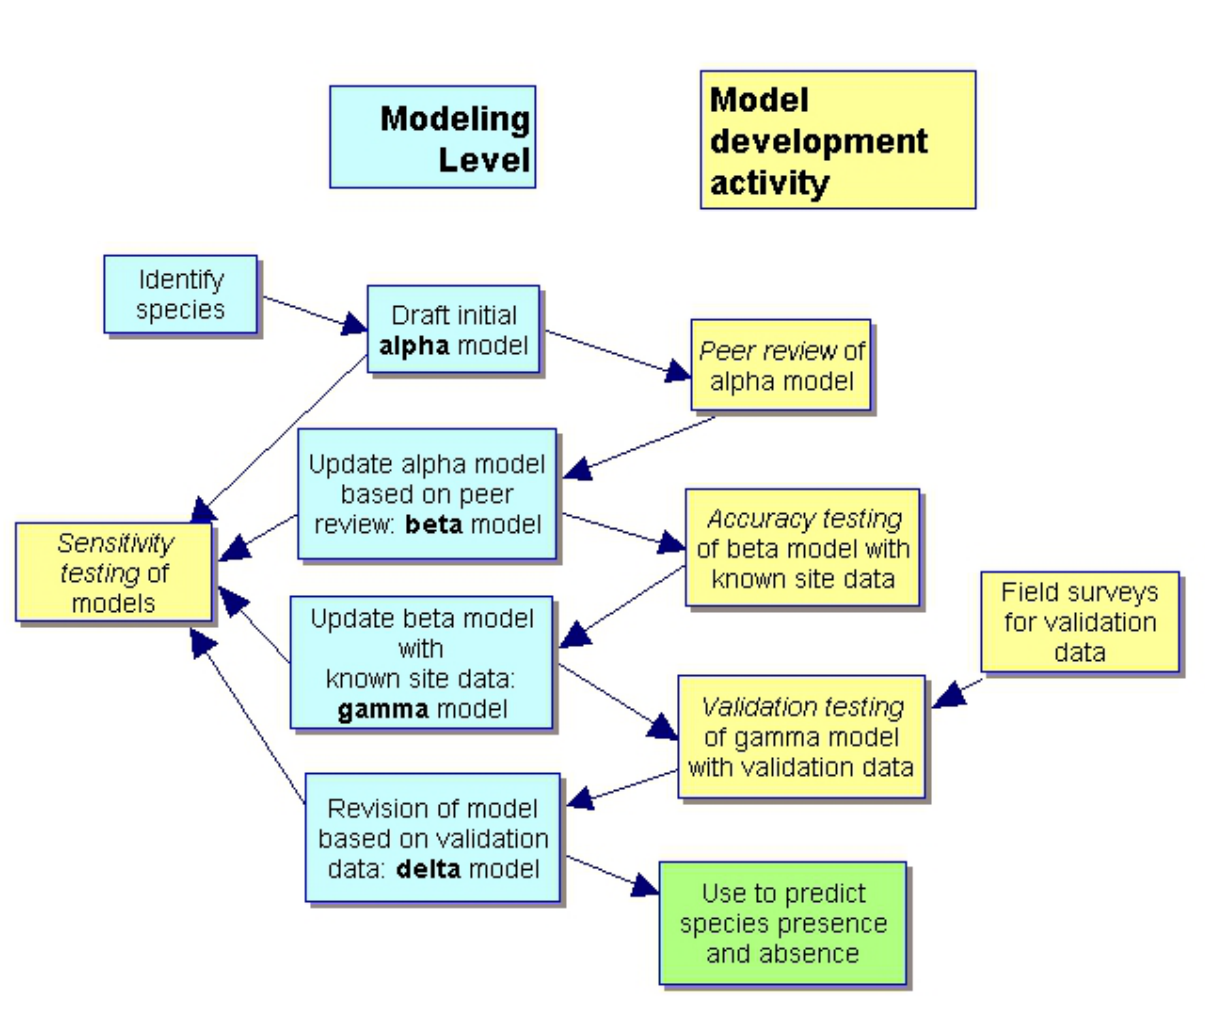
Fig. 1. Overall process of modeling rare species using Bayesian belief networks under the Northwest Forest